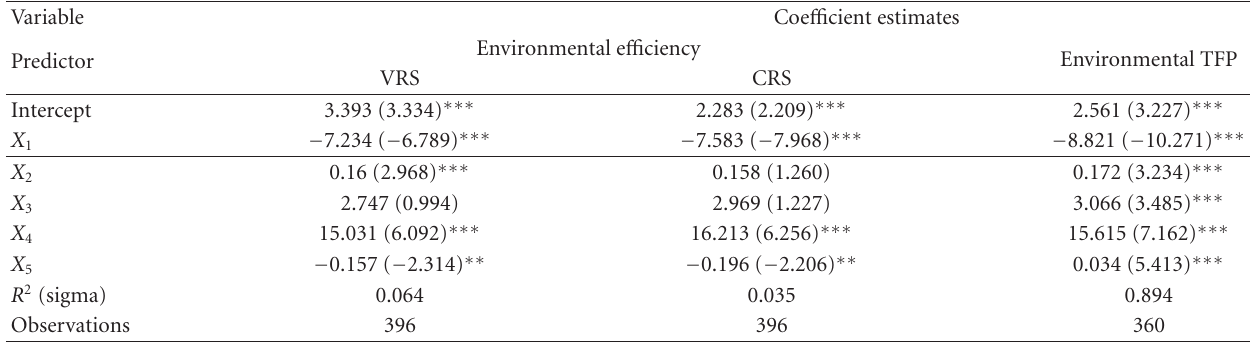
Table 3: Estimation results of environmental e ffi ciency and environmental TFP a